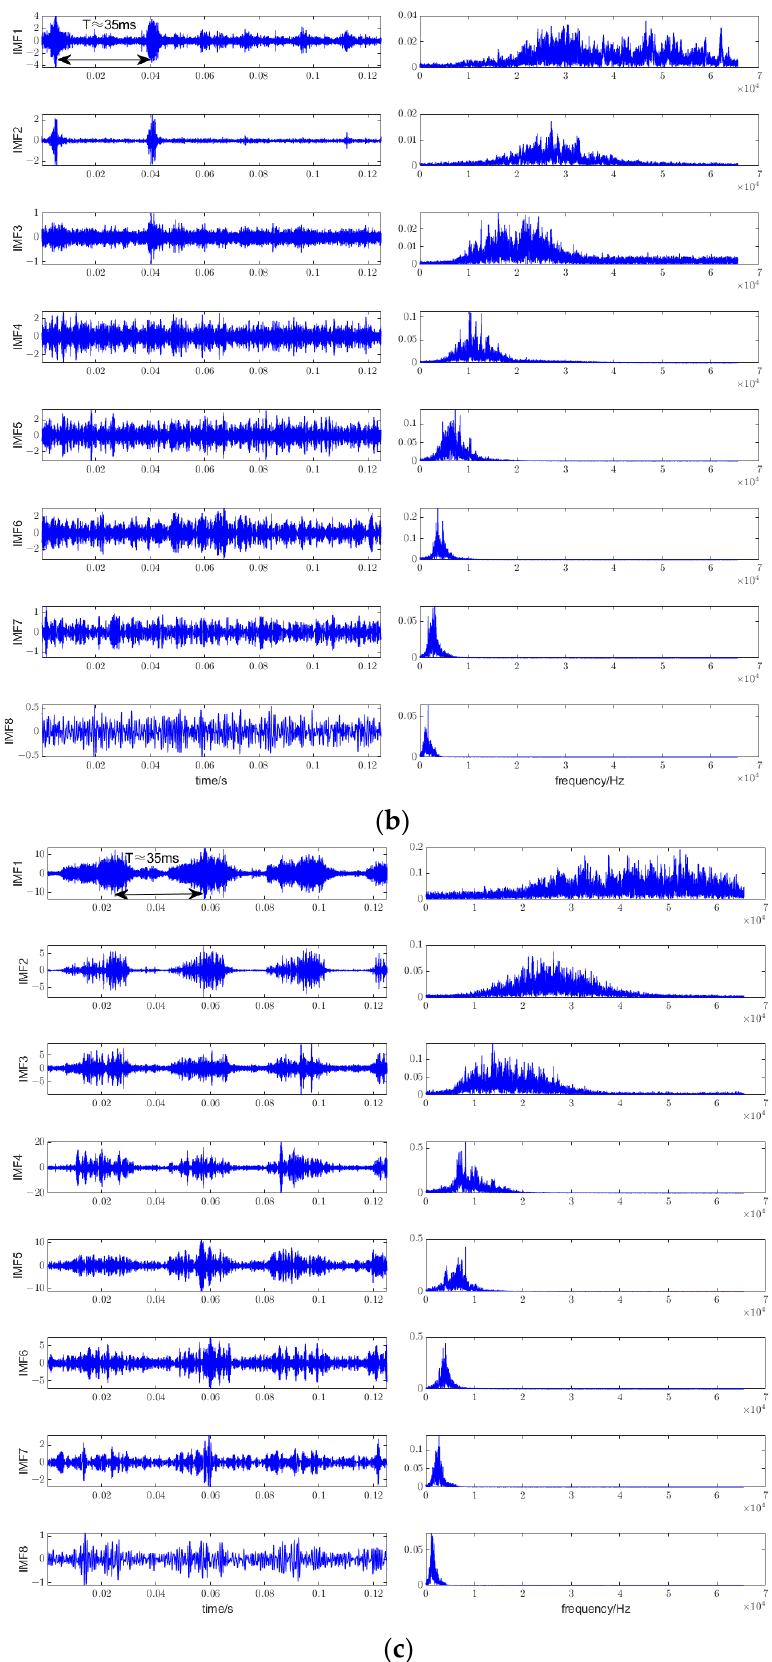
Figure 10. CEEMDAN results: ( a ) no cavitation; ( b ) cavitation inception; ( c ) full cavitation. In order to compare the effects of different multiscale entropy and decomposition meth- ods on cavitation feature extraction, three kinds of adaptive decomposition methods includ- ing CEEMDAN, EMD and VMD (variational mode decomposition) and three kinds of mul- tiscale entropy values including RCMFDE, RCMDE (refined composite multiscale disper- sion entropy) and MFDE (multiscale dispersion entropy) are adopted to calculate results of CEEMDAN-RCMFDE, CEEMDAN-RCMDE, CEEMDAN-MFDE, EMD-RCMFDE and VMD-RCMFDE, which are shown in Figure 11. Due to space limitation, only the computa- tion results of IMF1 are listed for analysis. It can be observed from Figure 11a that the en- tropy values of the measured noise in the three tests conditions are mixed together and not easy to recognize when the scale is small. As the scale increases, the entropy values in dif- ferent test conditions become easy to recognize, which illustrates the need for multiscale analysis. According to the comparison of Figure 11a – c, the dispersion degree of the entropy values of the three test conditions in Figure 11b,c is smaller than that in Figure 11a, indicat- ing that CEEMDAN classification method has a notably better effect on extracting cavitation features than EMD and VMD. In Figure 11d,e, it is still more difficult to recognize the result of different tests than in Figure 11a, indicating that the RCMFDE has a certain advantage over RCMDE and MFDE in judging the state of cavitation.